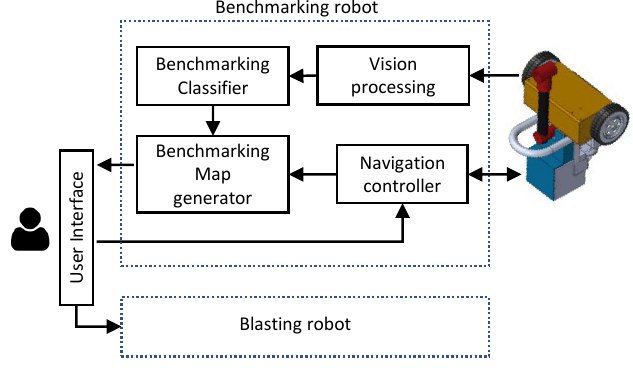
Figure 3. Functional overview.